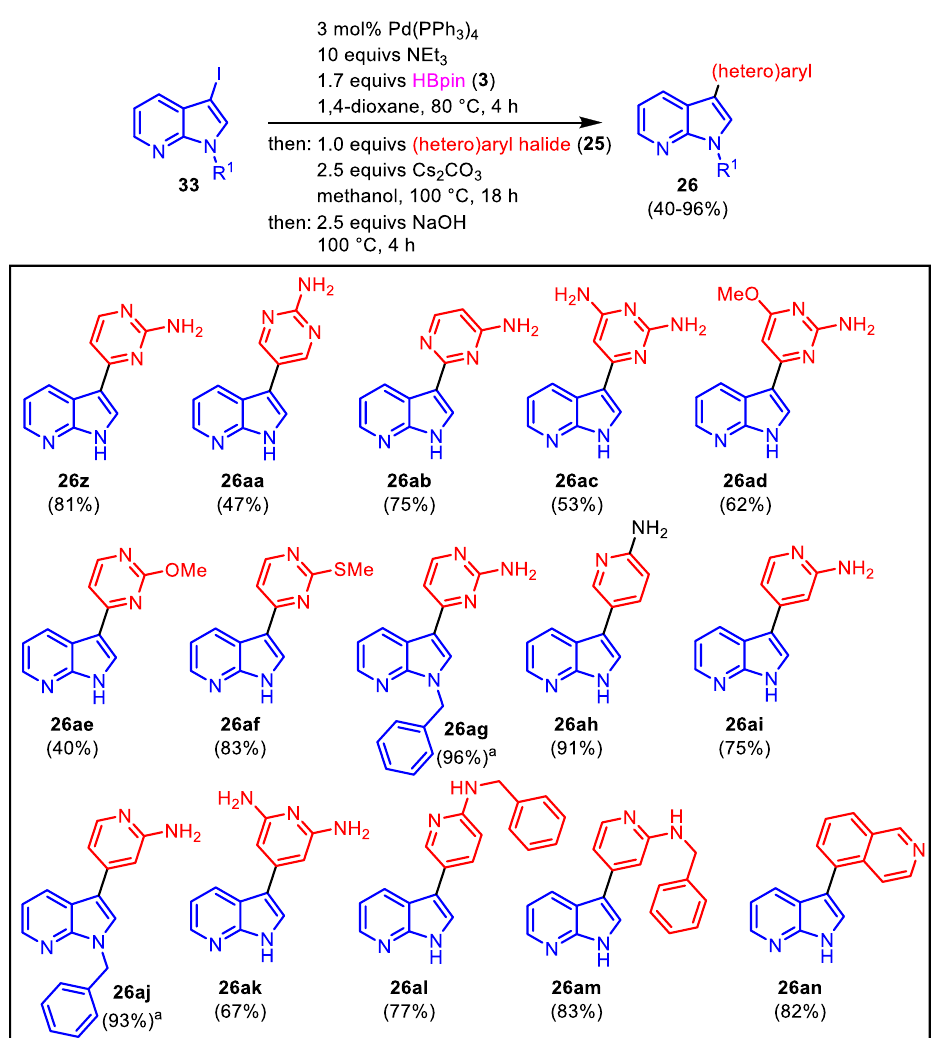
Figure 20. One-pot MBSC synthesis of meriolins 26 by Drießen et al. ( a Synthesis without deprotection step) [51].